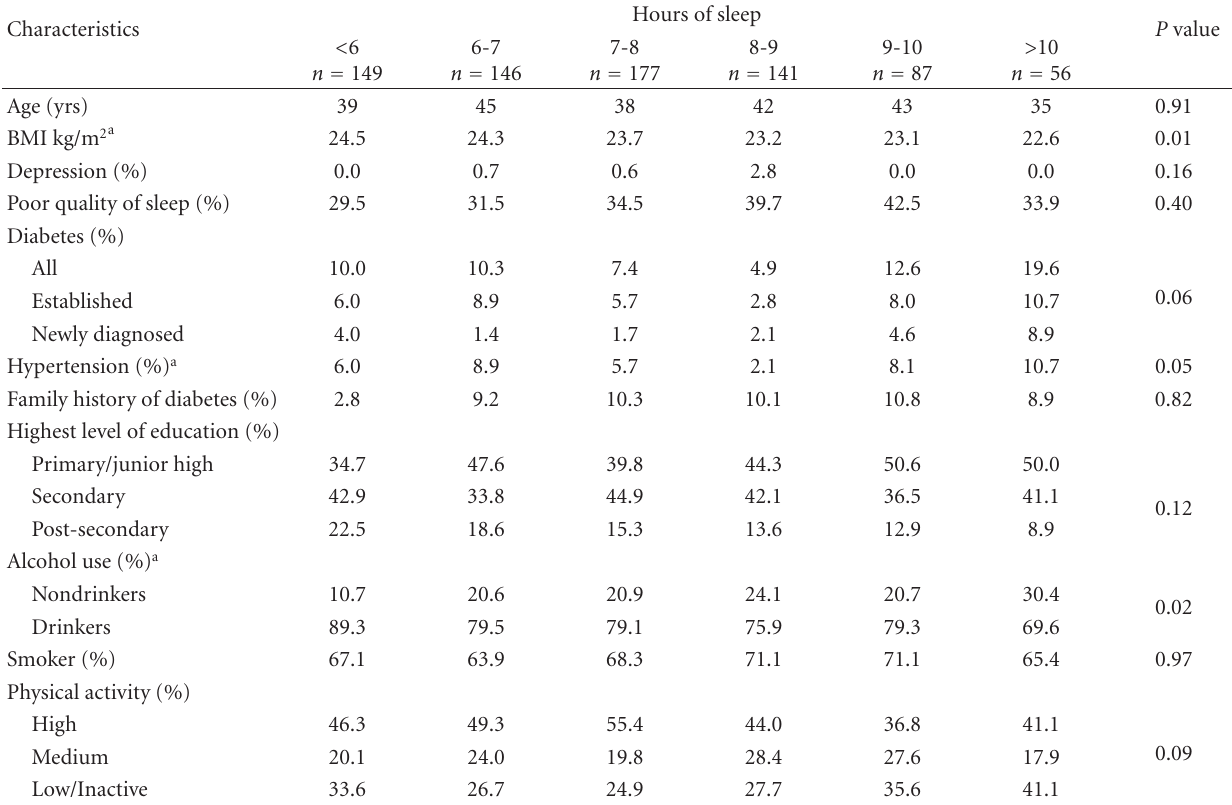
Table 2: Demographic, anthropometric, lifestyle factor and chronic disease prevalence, with self-reported hours of sleep in Jamaican men.